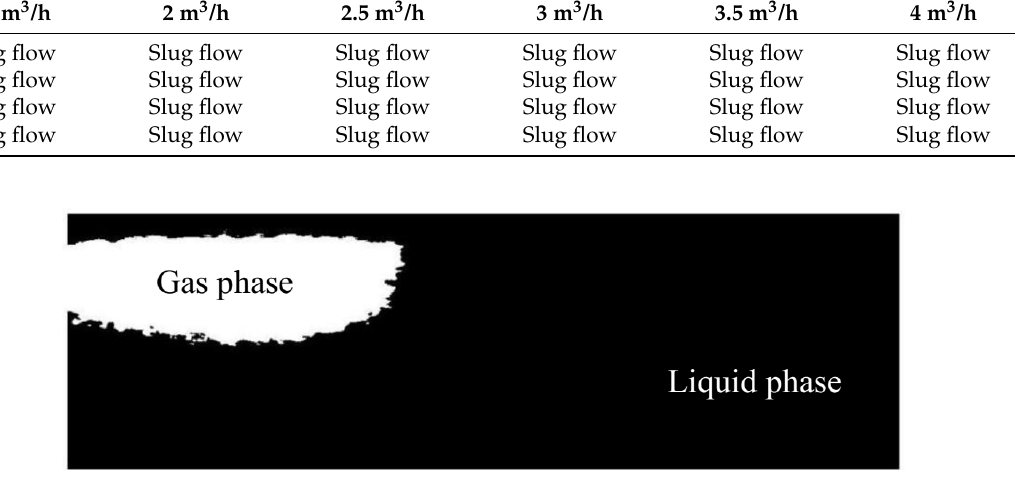
Figure 6. Image after image processing when the pressure is 0.15 MPa and tilted upward by 10°.